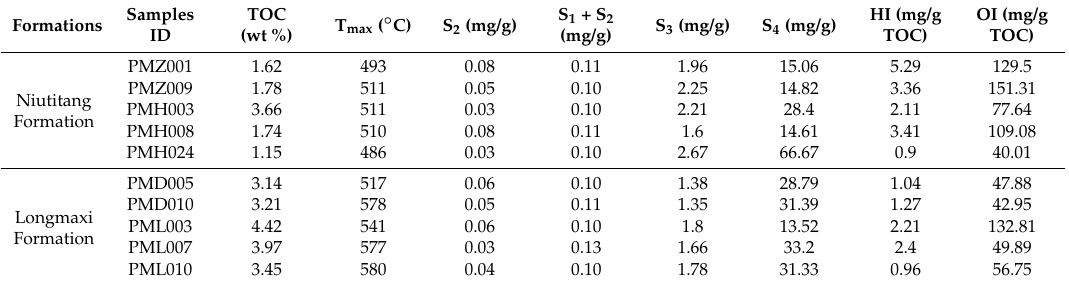
Table 3. Results of TOC and pyrolysis data of samples from Niutitang Formation and Longmaxi Formation.